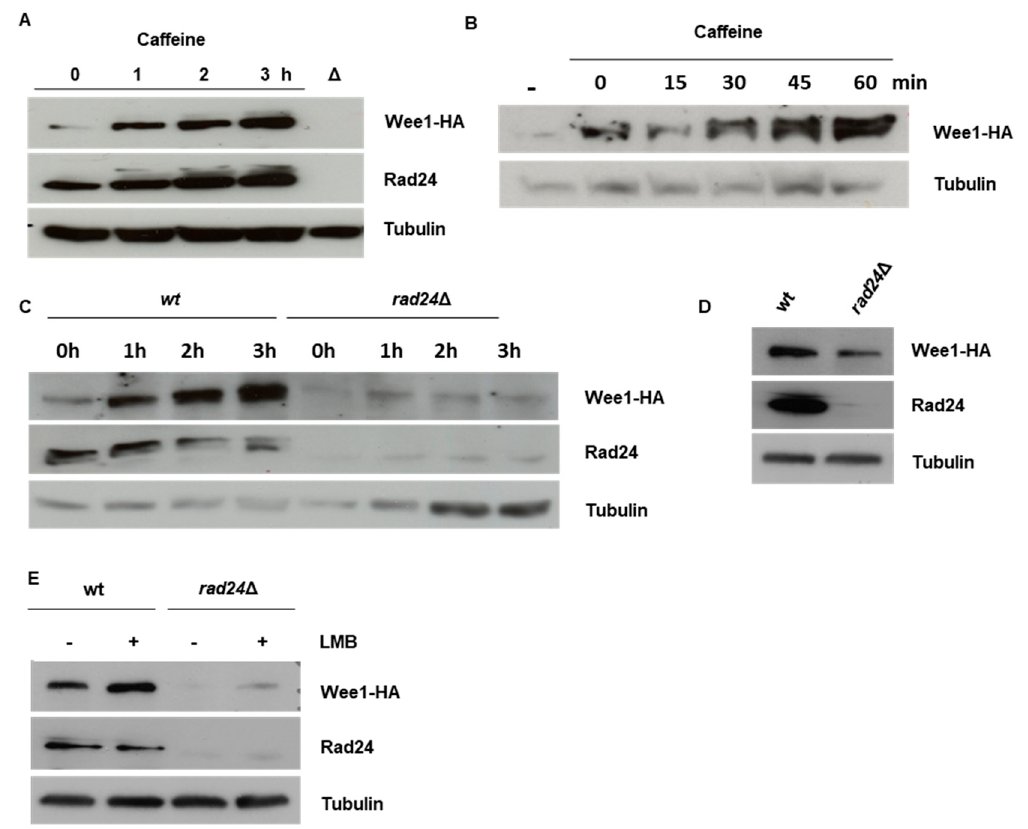
Figure 2. Caffeine induces Wee1 accumulation in a Rad24-dependent manner in S. pombe . ( A ). A Wee1-HA expressing strain was incubated with 10 mM caffeine and harvested at the indicated time points. Total protein lysates were resolved by SDS-PAGE. Wee1 was detected using antibodies directed against the HA epitope. Rad24 was detected using a pan 14-3-3 antibody. A rad24 ∆ mutant was used to monitor antibody specificity. Gel loading was monitored using antibodies directed against tubulin. ( B ). Cells expressing Wee1-HA were treated as in A. ( C ). Deletion of rad24 was carried out in a Wee1-HA expressing strain. Total protein lysates were resolved by SDS-PAGE and membranes probed with antibodies directed against HA and tubulin. ( D ). Wt and rad24 ∆ mutant cells expressing Wee1-HA were treated as in A. ( E ) Wt and rad24 ∆ mutant cells were exposed to 100 ng / mL LMB for 2h. Cell lysates were treated as in D.